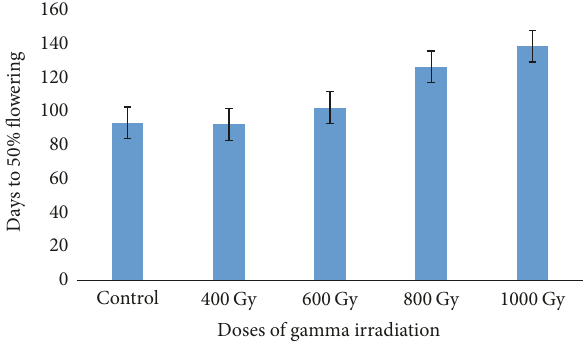
Figure 5: The effect of gamma irradiation on mean number of leaf.